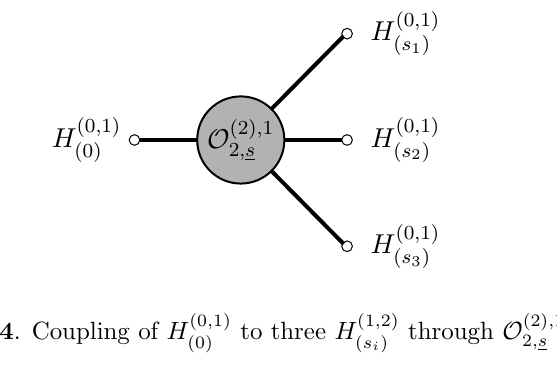
Figure 4 . Coupling of H (0 ; 1)